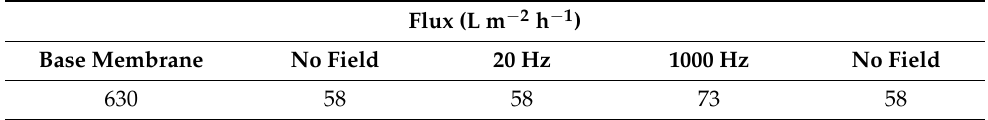
Table 1. Variation of water flux for inner pore and outer membrane surface modification. No flux was measured at 10.3 kPa for polymerization times greater than 1 h. Results are shown in the absence and presence of a 20 and 1000 Hz oscillating magnetic field. Average results are provided with a range of ± 8 L m − 2 h − 1 .